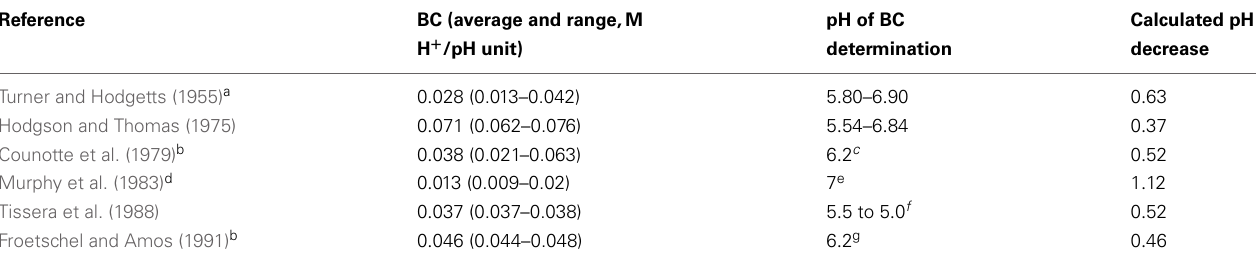
Table 1 | Ruminal fluid buffering capacity determinations and estimated maximal pH decrease for H 2 incorporation into reductive acetogenesis. Reference BC (average and